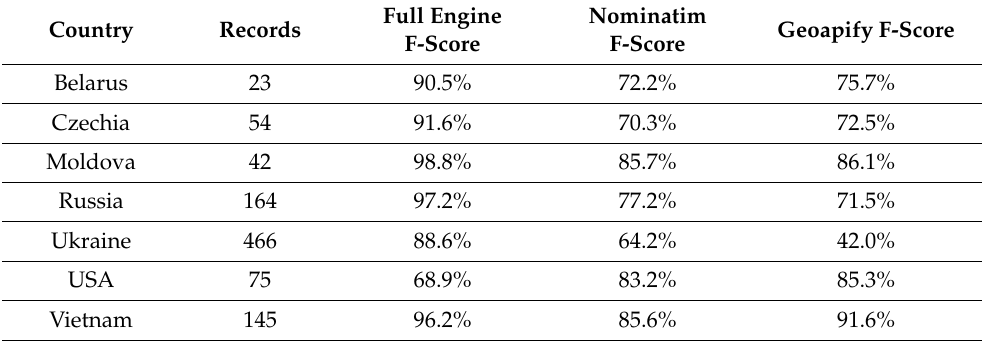
Table 3. Accuracy metrics for the main variant of the geocoding engine by input country, compared with third-party services. Countries with very few records are omitted. Source: our own